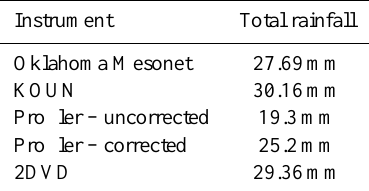
Table 3. Total rainfall accumulations for the 11 March 2007